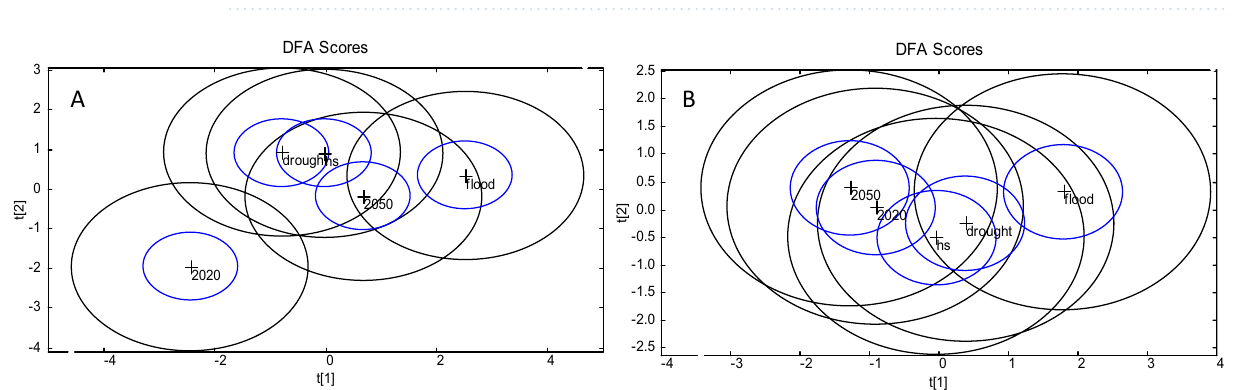
Figure 3. DFA analysis of liquid ( A ) and pellet ( B ) FTIR as affected for each climate scenario at the end of 48-h fermentation (DFA circles around the mean group centres with 95% confidence circles for DF1 vs DF2; HS heat